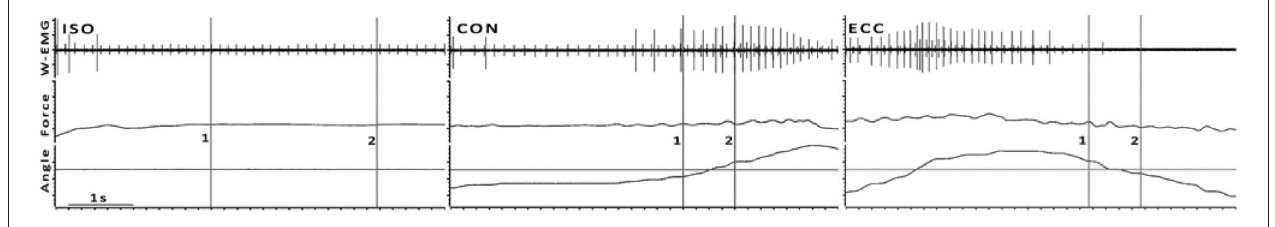
the horizontal cursor. This figure is a typical wire electrode recording (W-EMG), where the recruitment of an additional motor unit in CON and a derecruitment of active units in ECC can be observed (see Section Discussion for details).